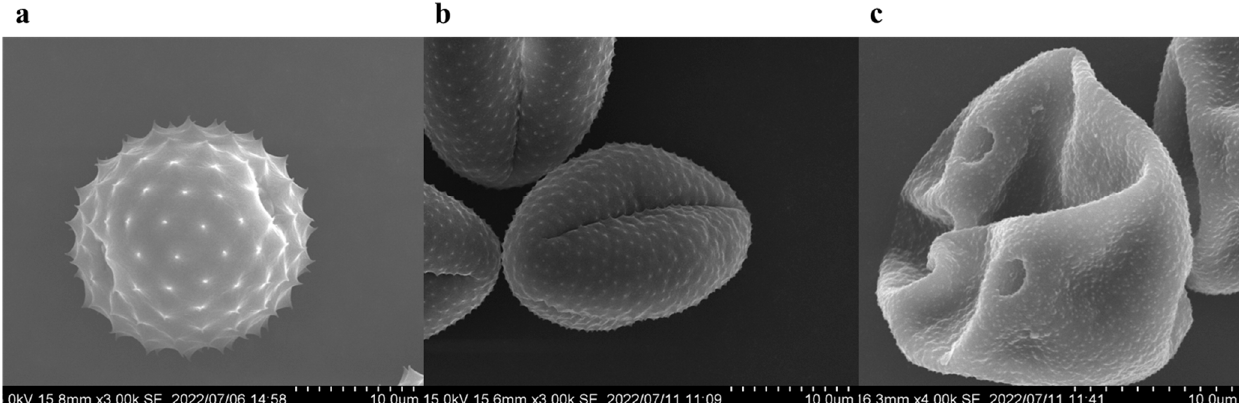
Figure 2. Physical characteristics of pollen measured using an SEM microscope, with an accelerating volage of 15.0 kV and a length of 16.3 mm, and SE image edition: ( a ) ragweed pollen, ( b ) mugwort, ( c ) Humulus japonicus .